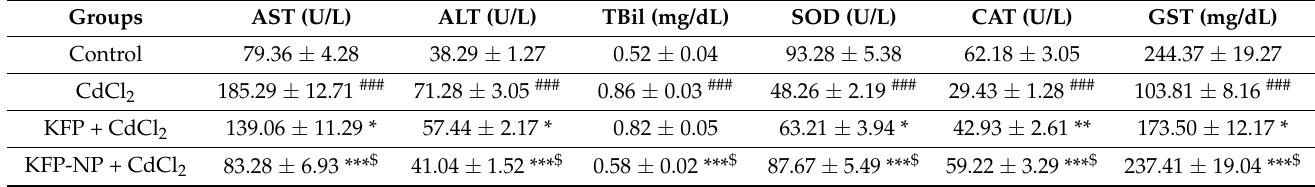
Table 4. Effect of KFP-NPs on serum liver function and antioxidant parameters in CdCl 2 intoxicated rat. Groups